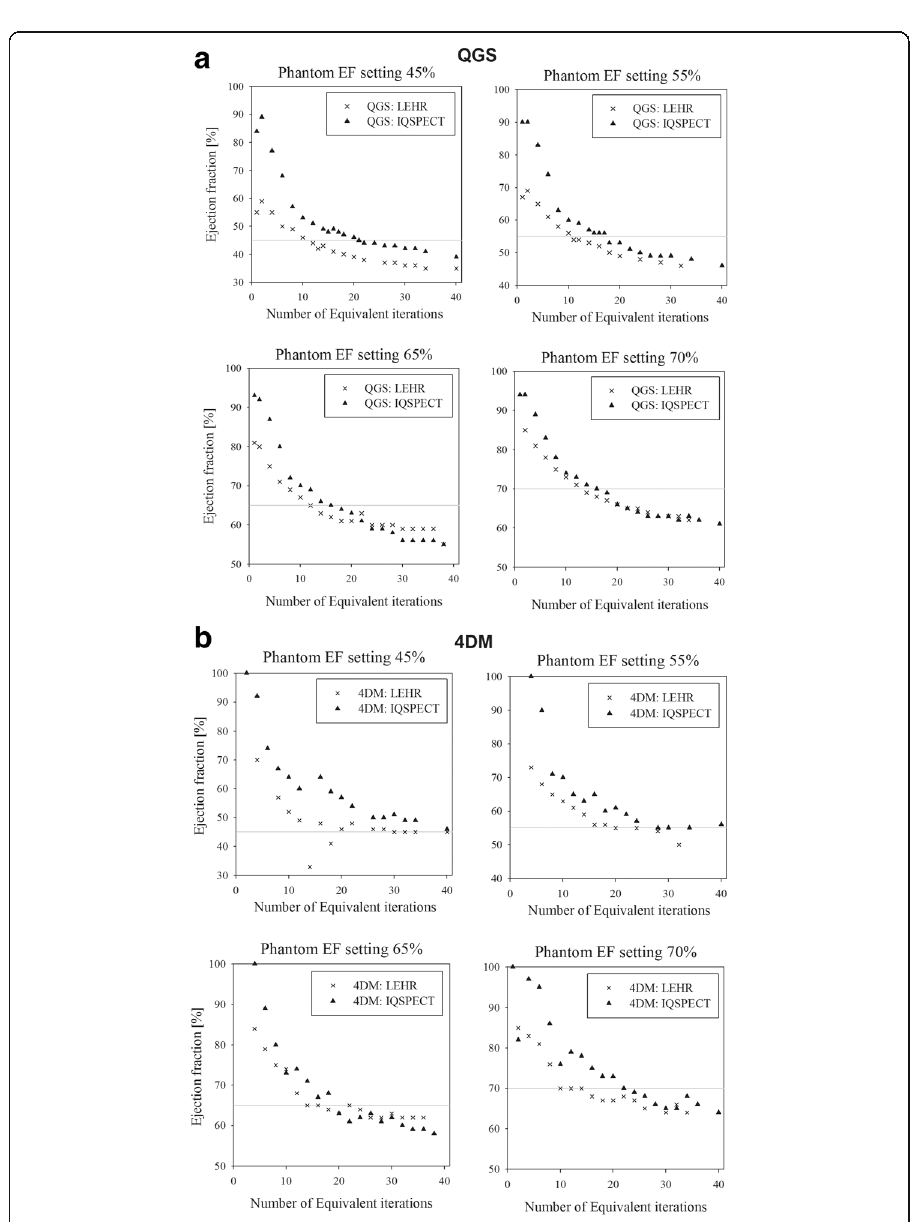
Fig. 5 EF LEHR and EF IQSPECT estimates as a function of number of reconstruction equivalent iterations for the dynamic heart phantom, analysed using a QGS and b 4DM software. The phantom was imaged with 45, 55, 65 and 70% EF settings ( grey solid line